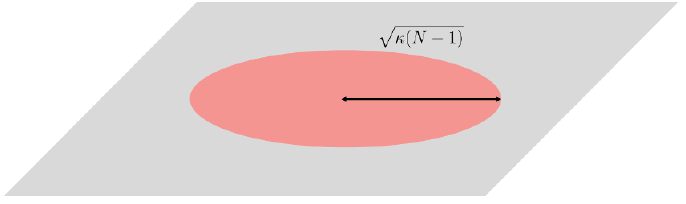
κ ( N 1) formed by N electrons on the − p